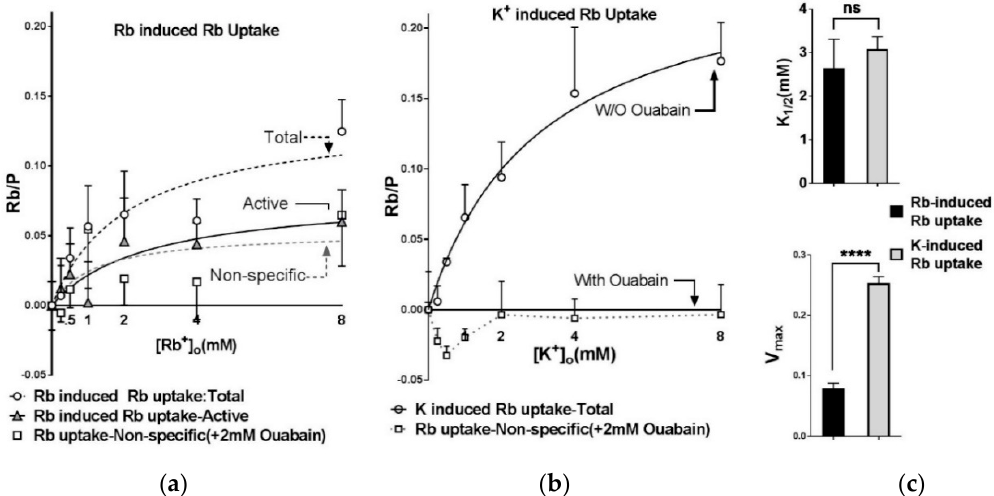
Figure 5. Apparent K + affinity of Na,K-ATPase determined from measurements of Rb + uptake in dissociated, intact EDL fibers of WT mice. ( a ) Rb-activated Rb + uptake. Samples of 2–5 fibers were incubated for 4 min in uptake solution containing 0 to 8 mM RbCl, in the absence of extracellular K + . The extracellular Rb + concentration was varied by equimolar replacement with choline chloride at constant osmolarity. Prior to the uptake period, samples were pre-incubated for 5 min in a Rb- and K-free Tyrode’s solution without ( ○ ) or with 2 mM ouabain ( □ ). Uptake was initiated by changing to the Rb-containing uptake solutions. The subtracted data at each [Rb + ] o ( (cid:78) ) represents the ouabain-sensitive, Na,K-ATPase component of Rb + uptake. Each symbol represents the mean and SEM of 40 and 37 samples for active and non-specific Rb-induced uptake, respectively. Solid and dashed lines represent best fit curve to the Michaelis–Menten equation. ( b ) K-activated Rb + uptake. Same protocol for uptake solution containing 0–8 mM K + and 500 µM Rb + (tracer). Each symbol represents the mean and SEM of 38 and 39 samples for active and non-specific K-induced Rb + uptake, respectively). ( c ) The extracellular